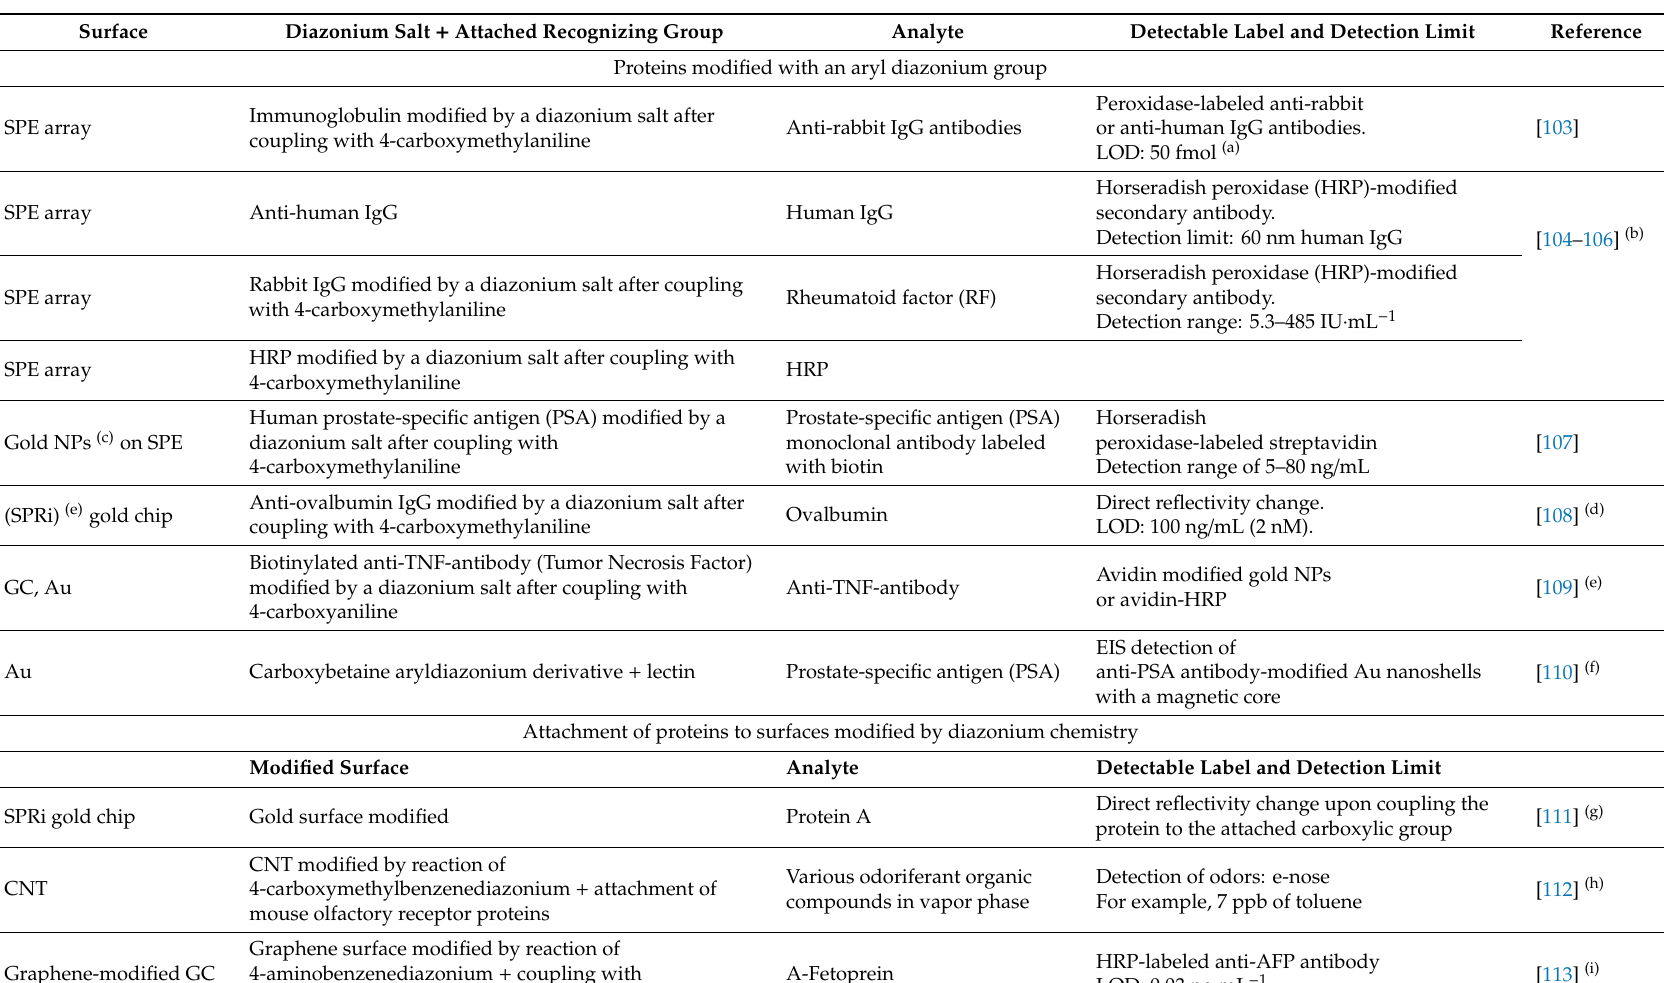
Table 4. Detection of proteins. IgG—immunoglobulin